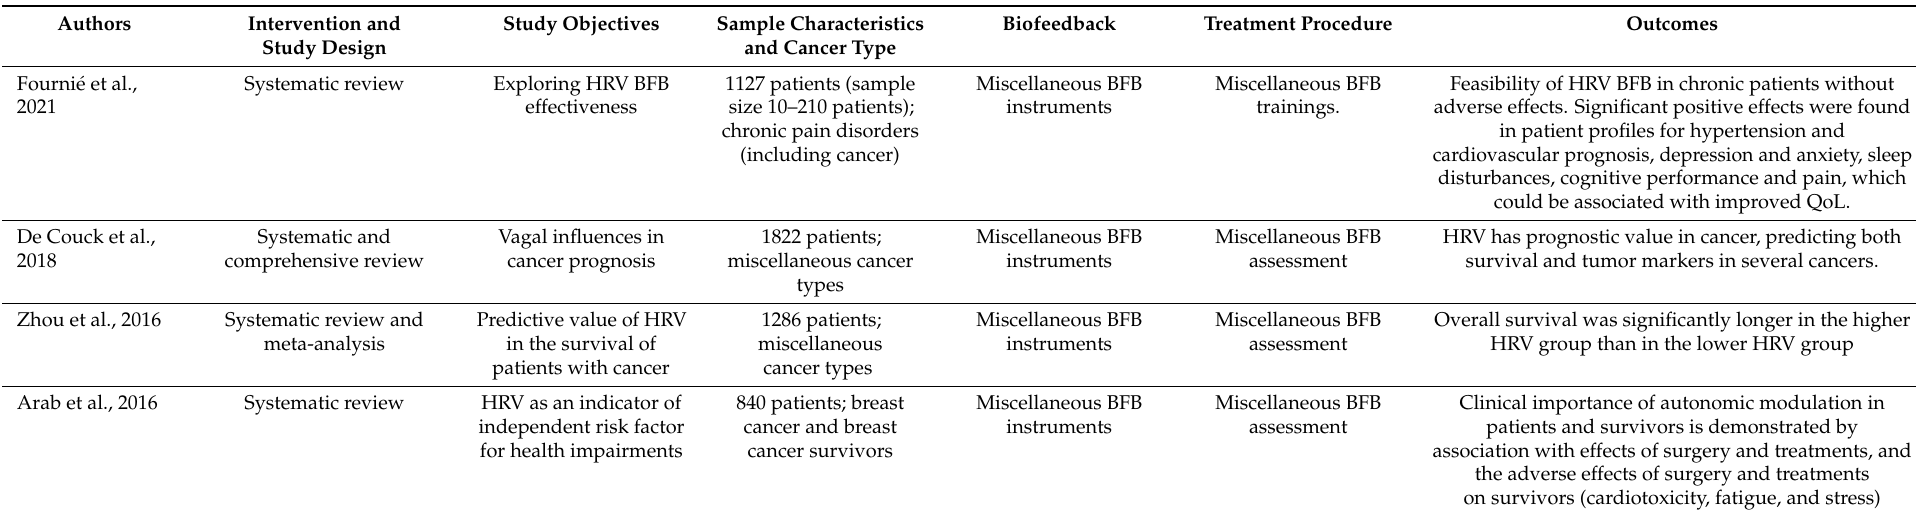
Table 2. Theoretical Studies Characteristics and